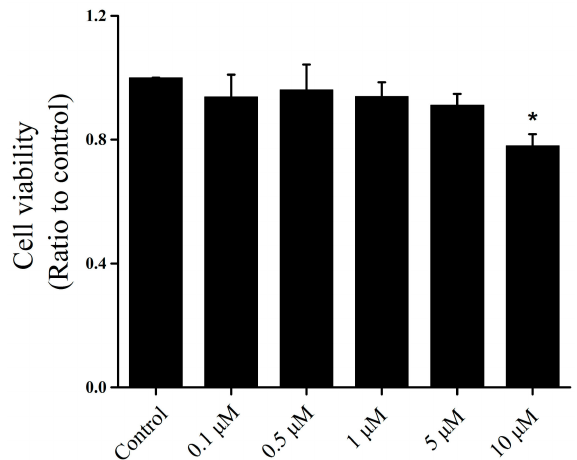
Figure 1. Effects of icariin on cell viability of osteoarthritis fibroblast-like synoviocytes (OA–FLSs).